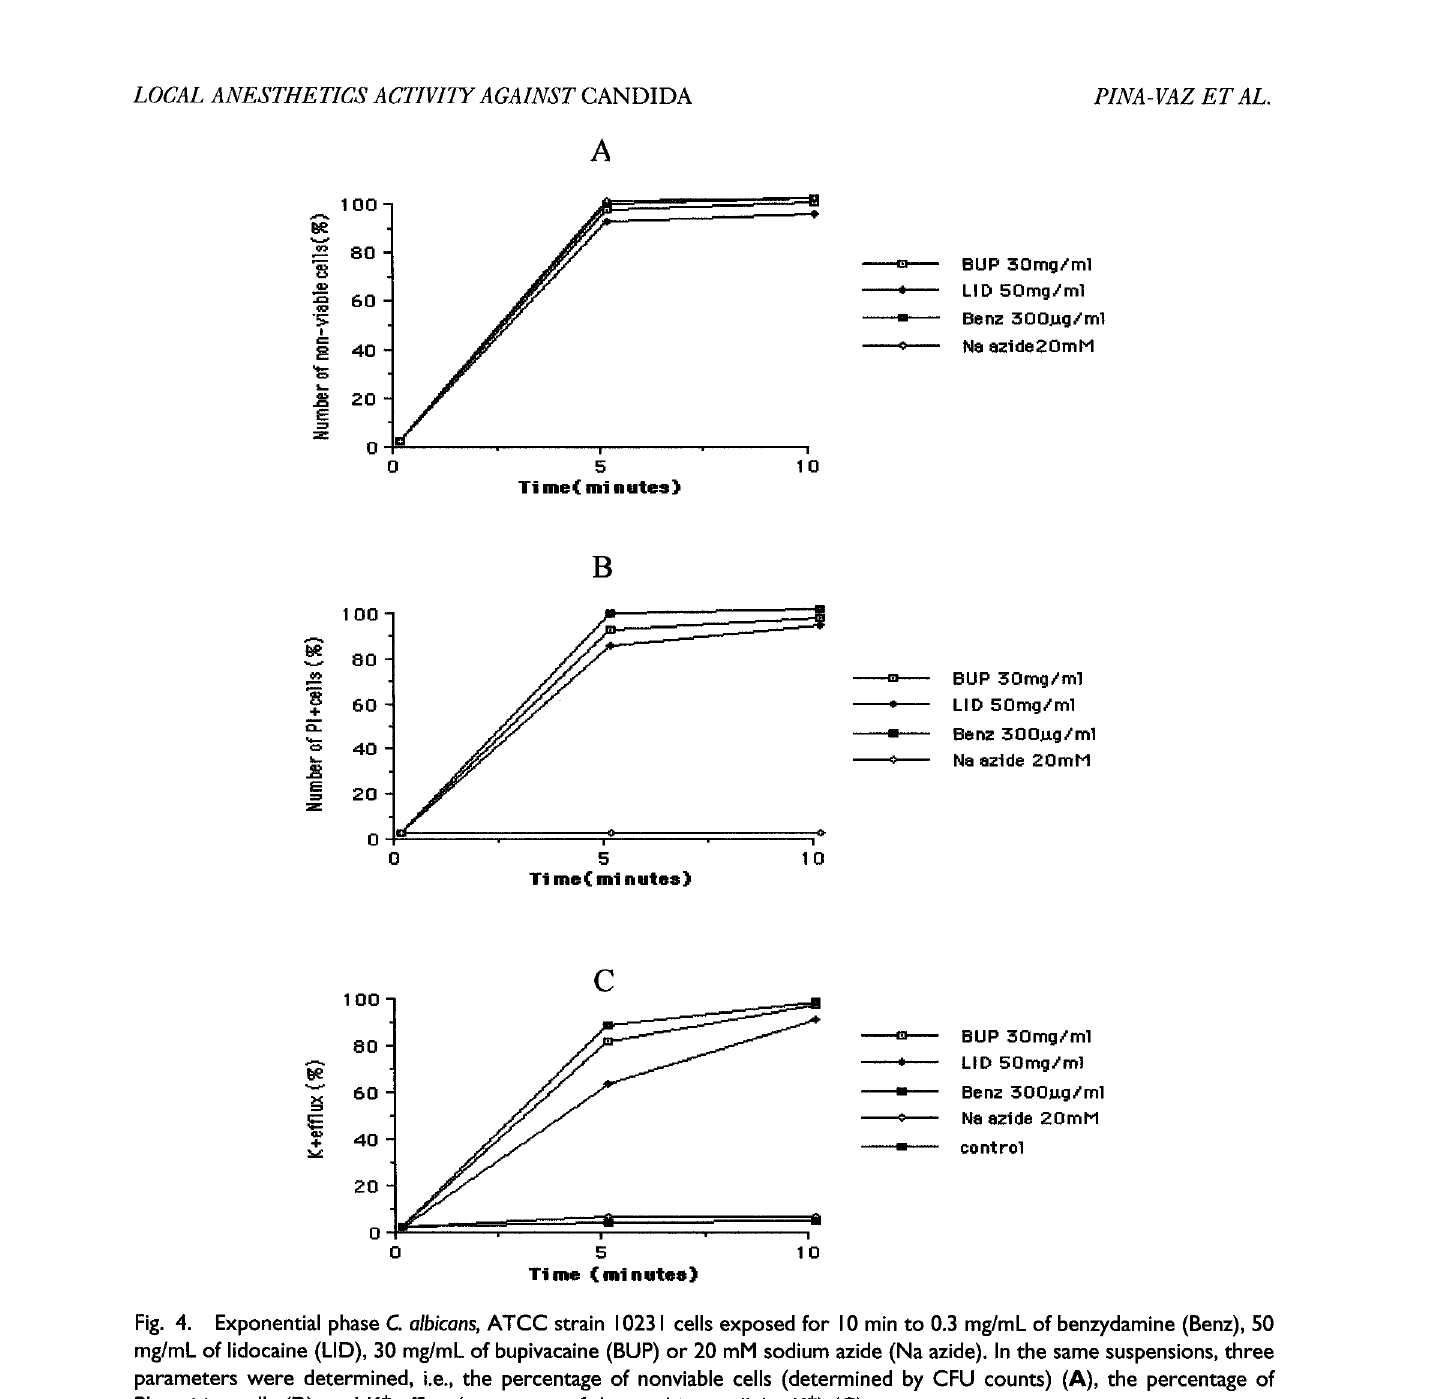
trifuged at 1800g for 10 minutes and the pellet re- suspended in GH medium supplemented with